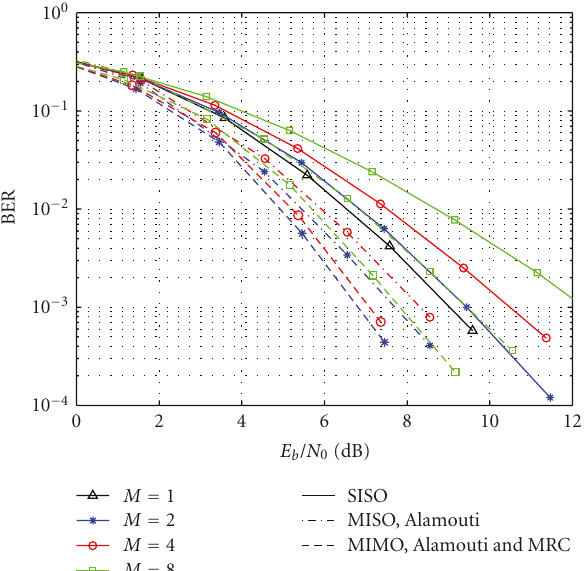
Figure 3: Coded performance for B-IFDMA with instantaneous data rate 1.11 Mbps, that is, Q = 32 subcarriers per user with normalized antenna gain.